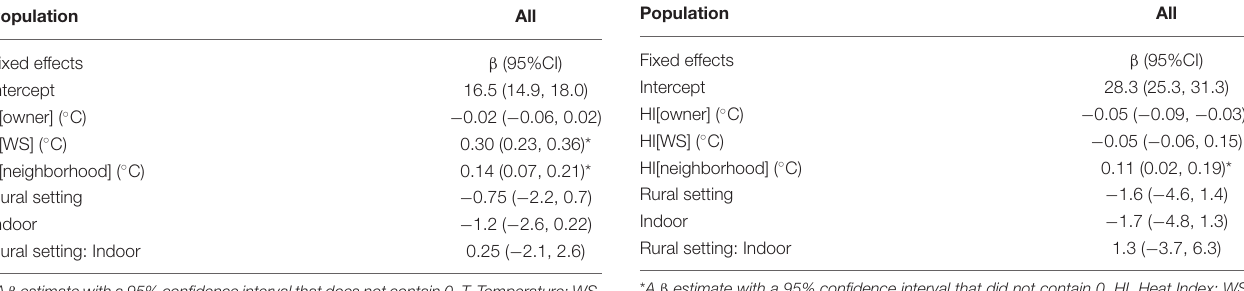
TABLE 3 | Linear mixed effect model results with dog’s individually experienced temperatures over 24h as the outcome. Population